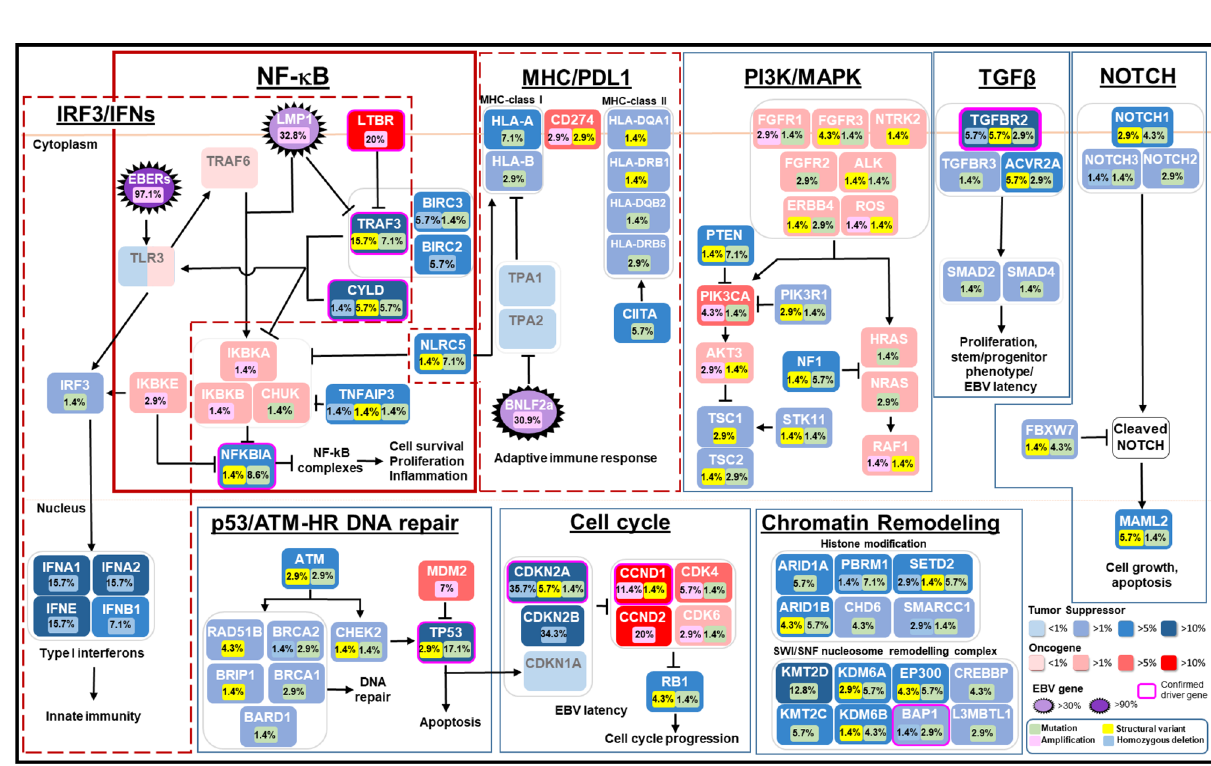
Fig. 6 Frequently altered cancer pathways in NPC at the whole-genome level. Multiple genomic aberrations and EBV latent genes alter multiple cancer pathways in